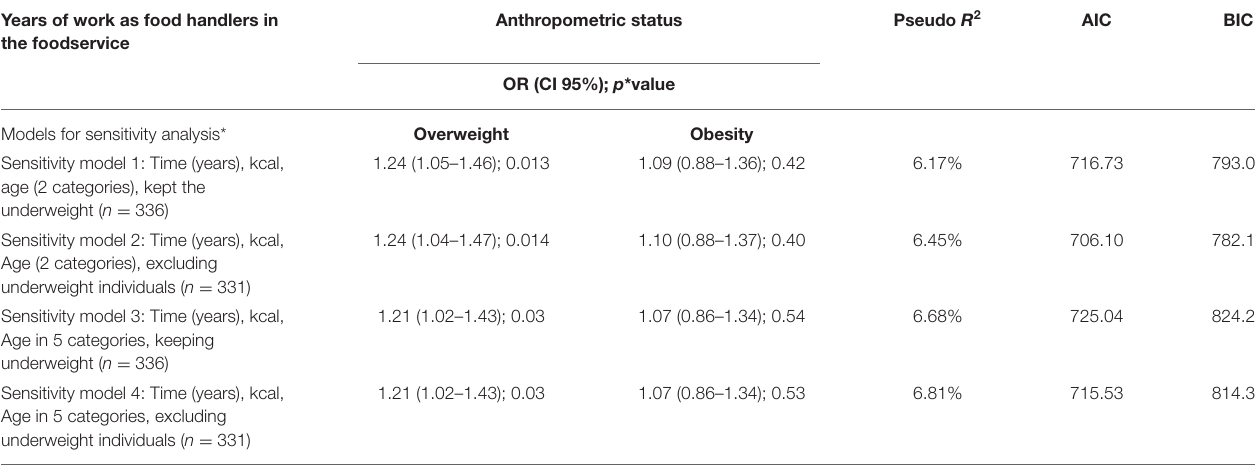
TABLE 4 | Sensitivity models performed with a subsample of the study population. Years of work as food handlers in the foodservice